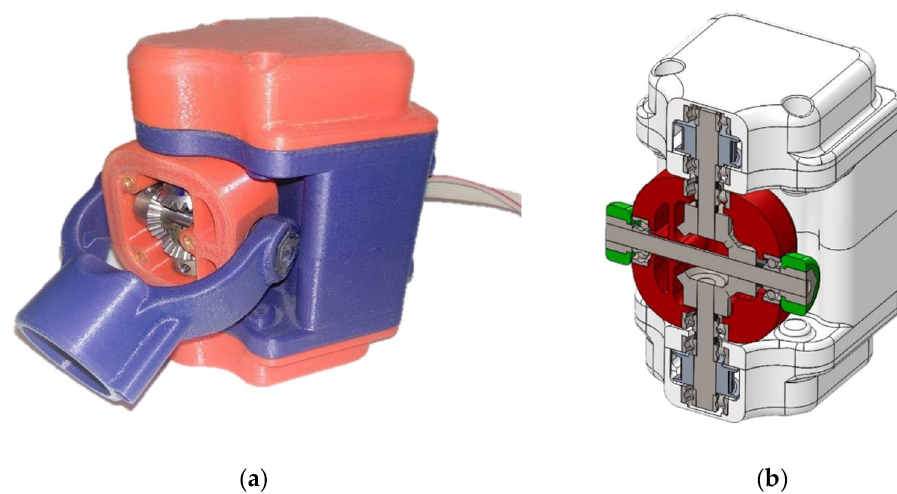
Figure 3. Differential gear drive ( a ) prototype; and ( b ) cross-section of its CAD model.